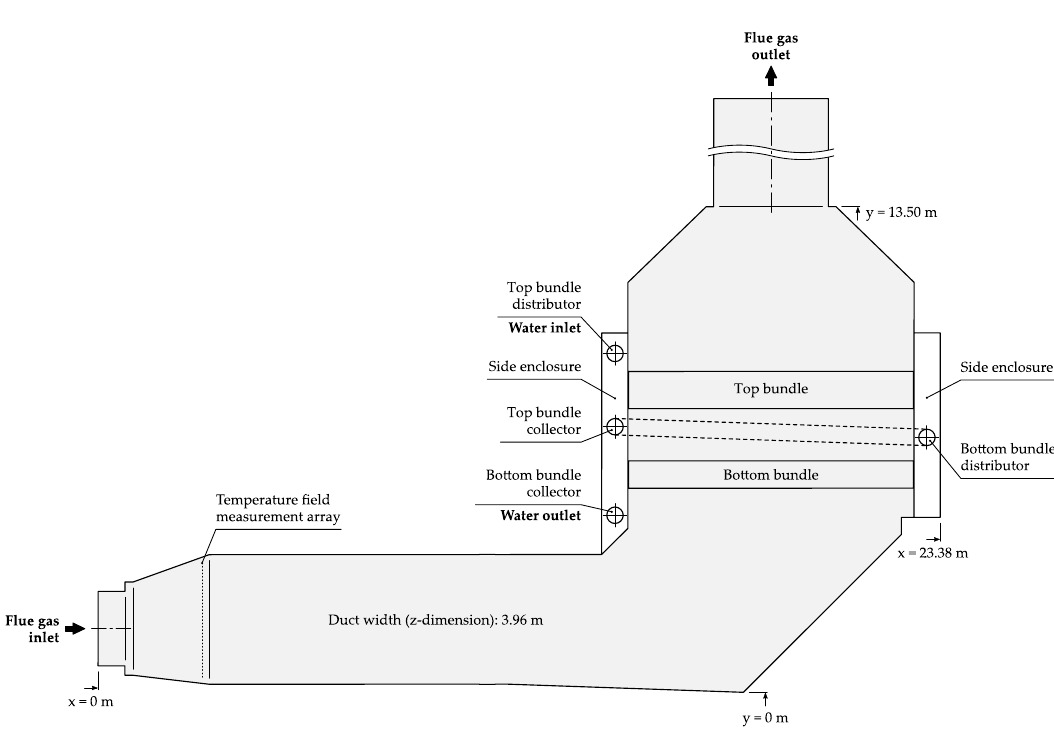
the operator of the boiler in the course of a guarantee test.